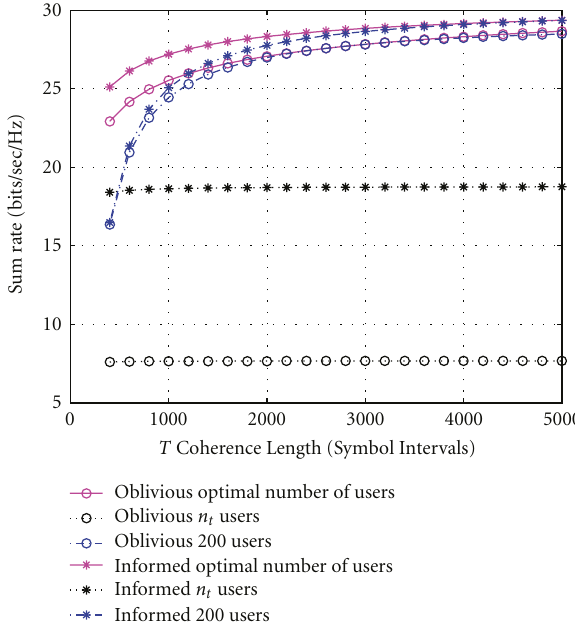
Figure 8: Sum rate with optimal number of users versus coherence